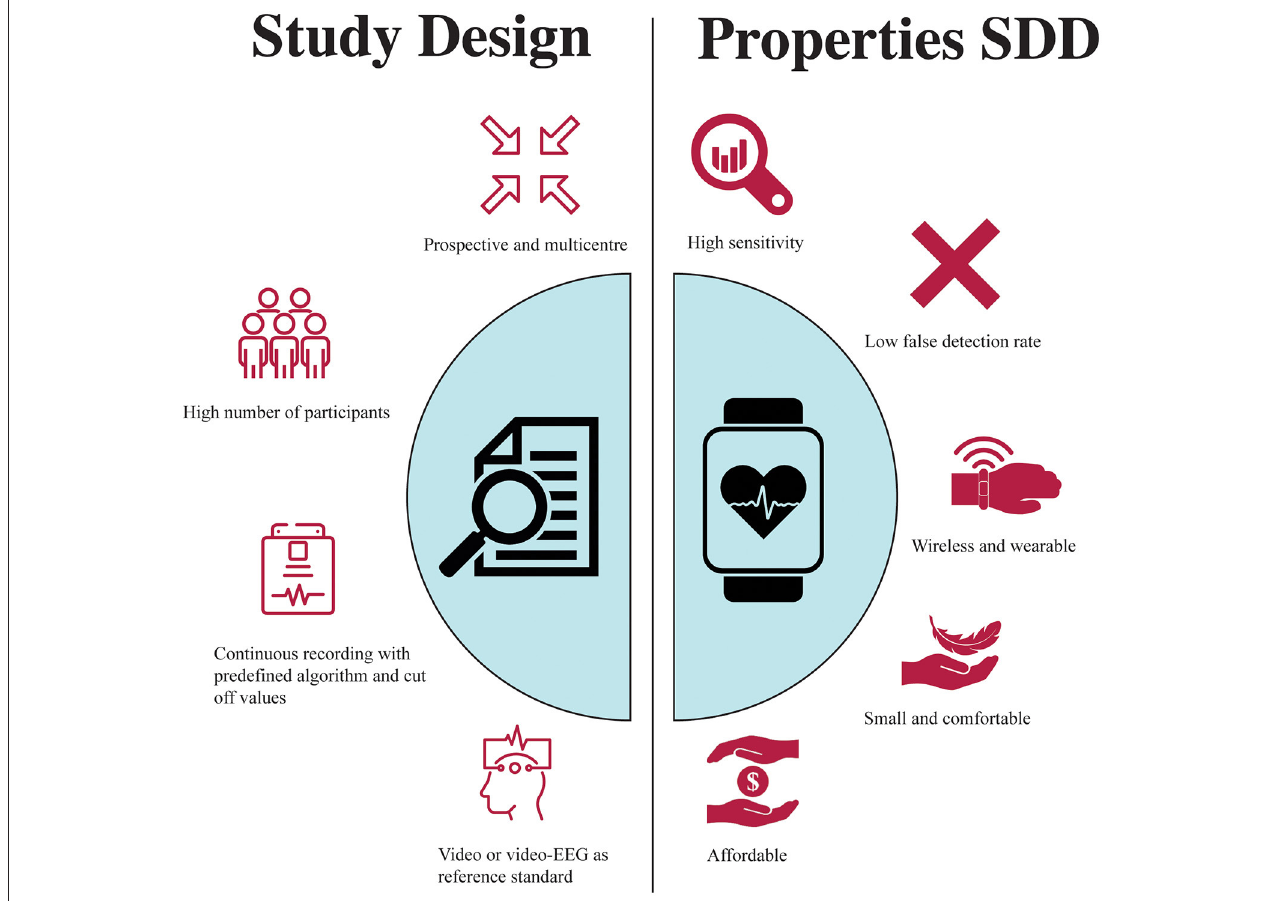
FIGURE 1 | Key features Seizure Detection